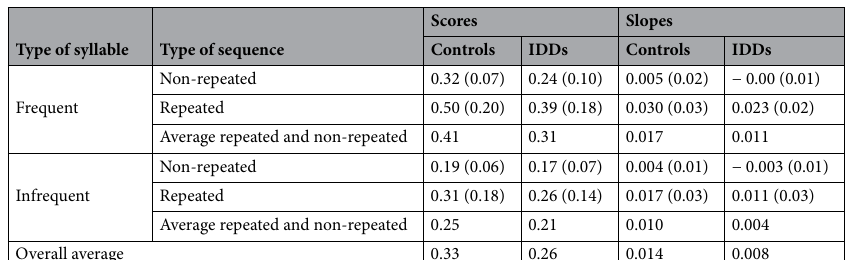
Table 1. Hebb learning: mean scores and slopes. Scores (mean (SD)) and slopes (mean (SD)) of Hebb repetition-learning with frequent and rare syllables. The score for each sequence was between zero and one: zero if none of the nine syllables composing the sequence was recalled correctly with respect to both its identity and serial position, and ~ 0.11 for each correctly recalled syllable. The total score for each participant for each condition is the average of the sequences’ scores. The slopes of the regression lines were calculated for each individual in each condition based on performance as a function of trial number.